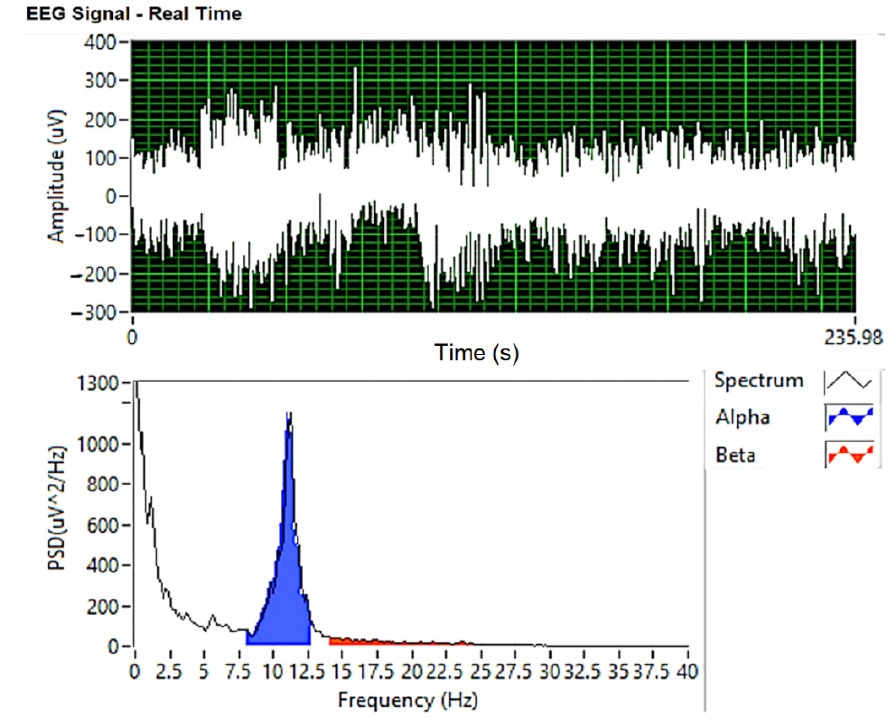
Figure 16. Frequency spectrum for alpha and beta brain waves when eyes are